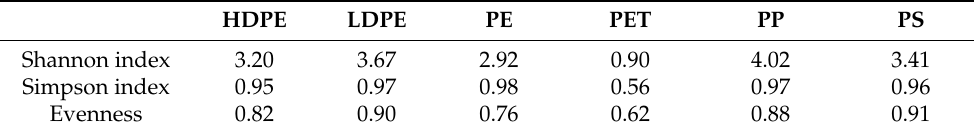
Table 1. Calculated diversity indices (Shannon-index; Simpson-index) and evenness for each poly- mer.